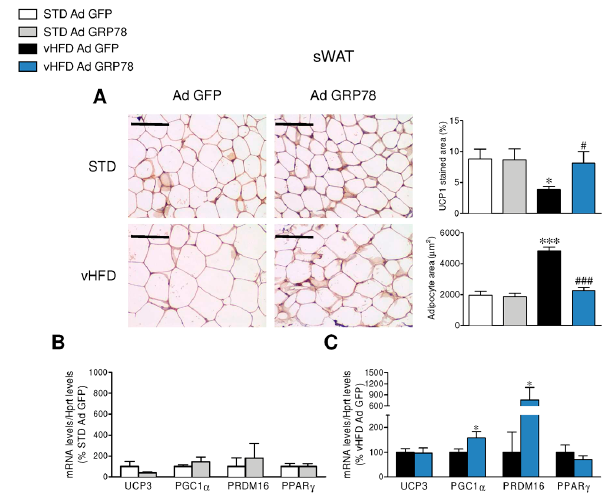
Figure 4. Effect of GRP78 overexpression in the VMH of vHFD rats on subcutaneous WAT (sWAT) browning. ( A ) Representative immunohistochemistry with anti-UCP1 antibody showing UCP1 staining (left panels; original magnification 20×; scale bar 100 µm), UCP1 stained area (right upper panels; n = 8–10 animals per group), adipocyte area (right lower panels; n = 8–10 animals per group) and ( B , C ) relative mRNA levels of thermogenic markers ( n = 8–10 animals per group) in the sWAT of the STD or vHFD rats stereotaxically treated with GFP or GRP78 adenoviruses into the VMH. Statistical significance was determined by t -Student test or ANOVA. Error bars represent the SEM. * p < 0.05, and *** p < 0.001 vs. (STD or vHFD) Ad GFP; # p < 0.05 and ### p < 0.001 vs. vHFD Ad GFP (panel A ).